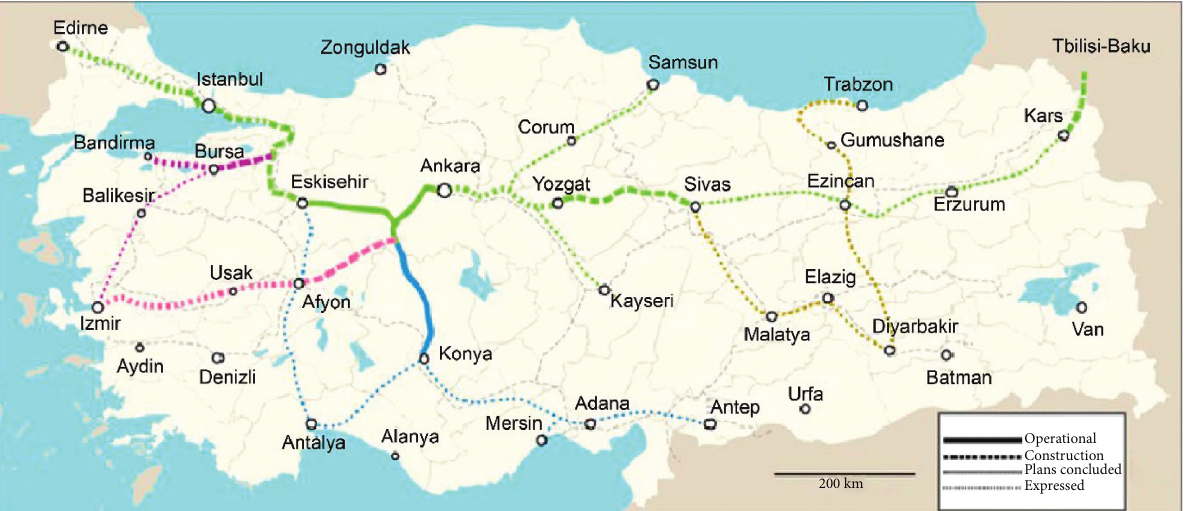
Figure 1: Destinations of the HSTs from Ankara. Table 4: Investigation of relationships between variables affecting